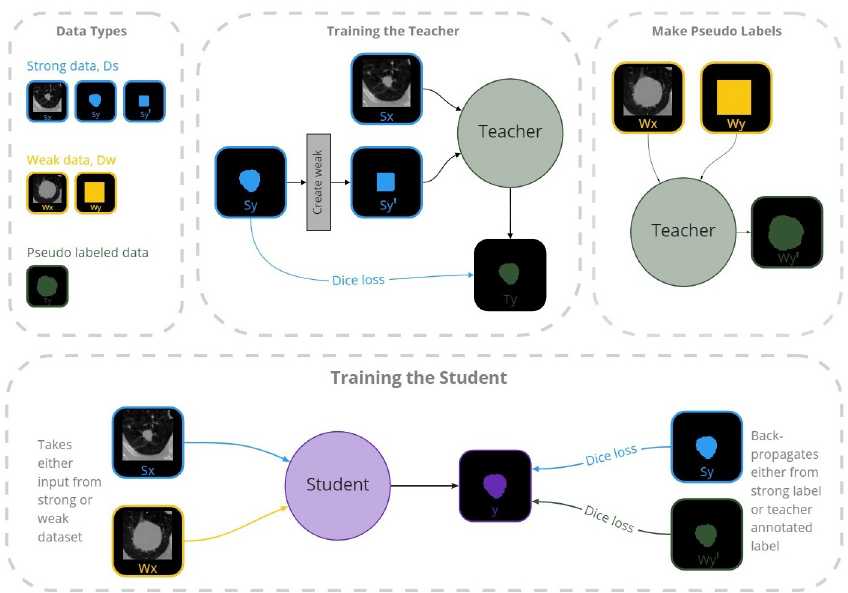
Fig 1. The method overview during training. Firstly, the teacher was trained using the strong dataset (semantic annotated images) represented with blue lines. The teacher was then used to make semantic annotations for the weak dataset (bounding box annotated images). The student was then trained on both the pseudo-annotated dataset D represented by the orange lines, and the strong dataset D s .